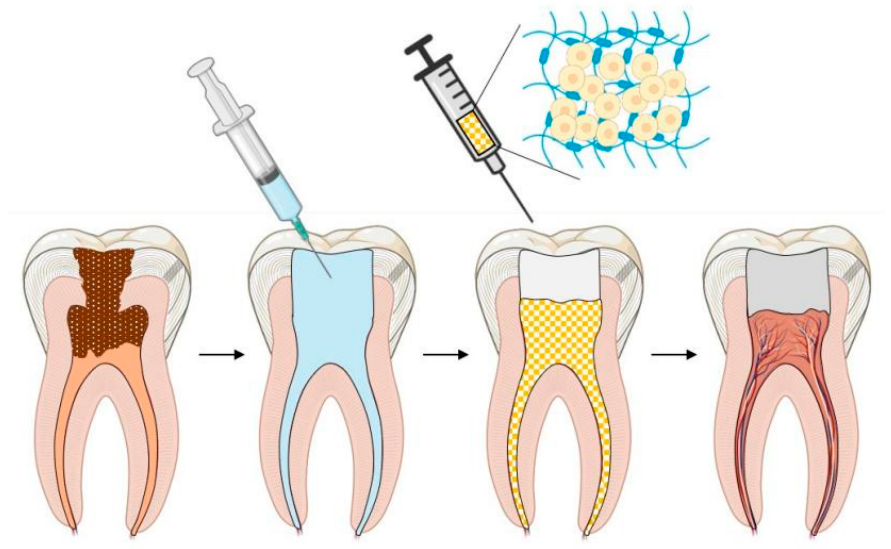
Figure 2. Schematic illustration of ideal pulp regeneration procedure.